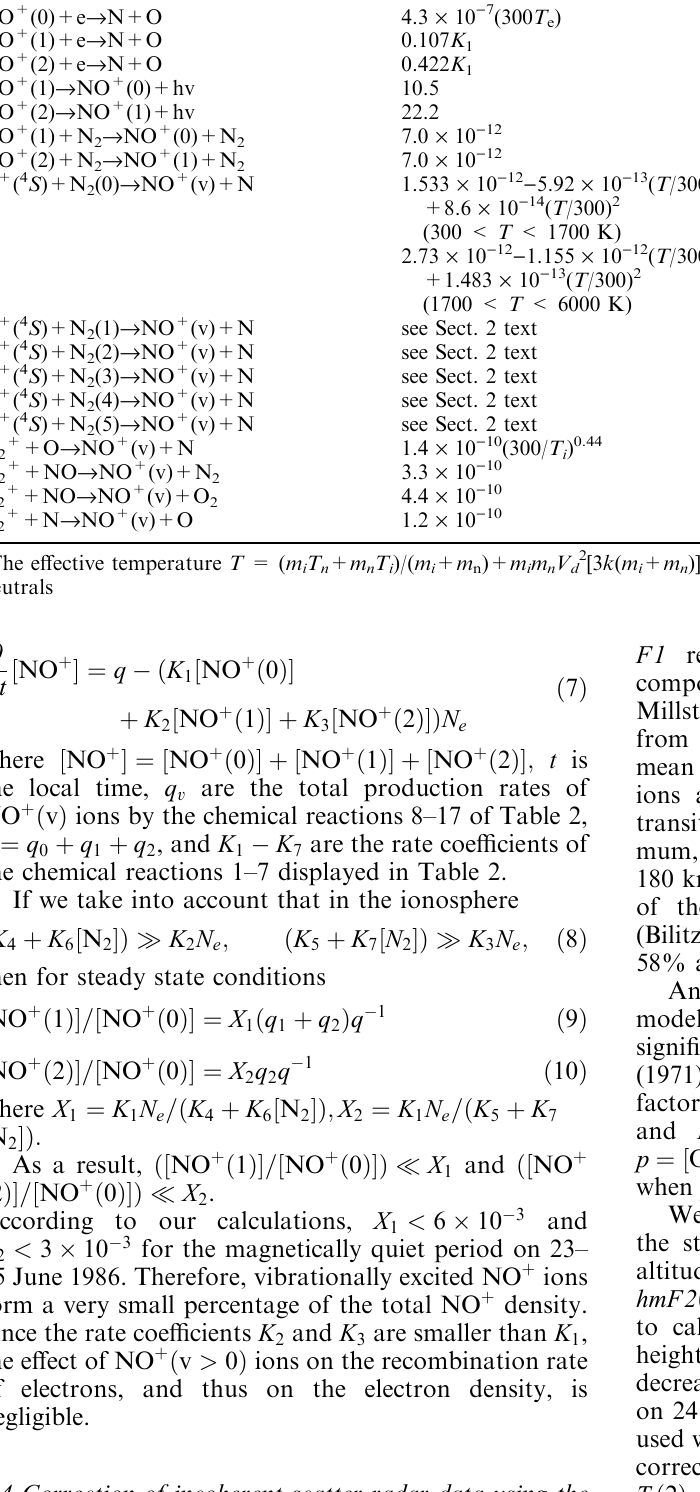
Table 2. Chemistry of unexcited (v = 0) and vibrationally excited (v = 1, 2) NO + (v) ions